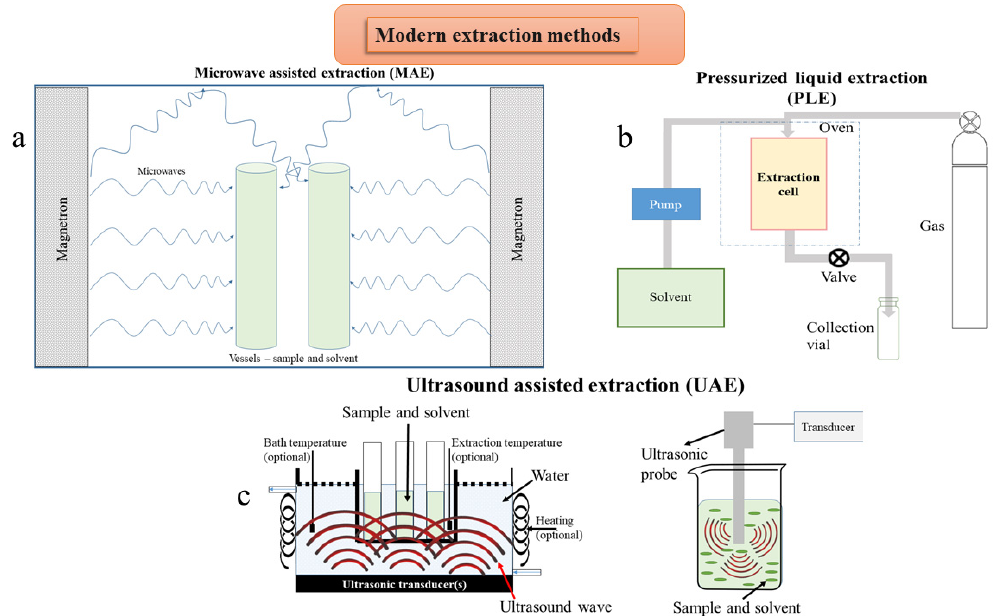
Figure 3. Schematic representation of modern extraction techniques: ( a ) microwave assisted extraction; ( b ) pressurized liquid extraction; ( c ) two setups for ultrasound assisted extraction.